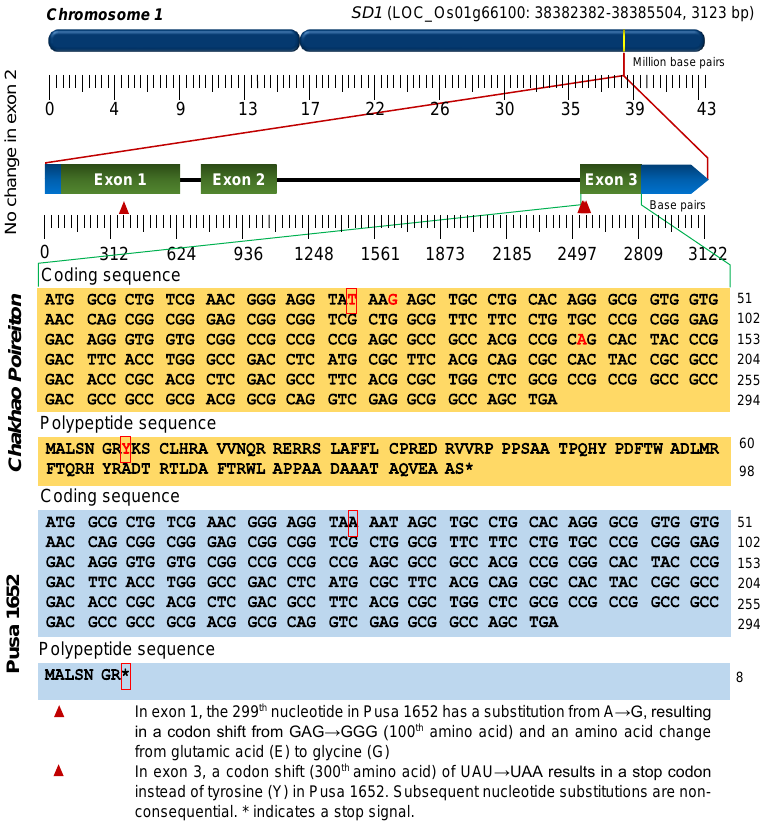
from glutamic acid (E) to glycine (G) In exon 3, a codon shift (300 th amino acid) of UAU→UAA results in a stop codon instead of tyrosine (Y) in Pusa 1652. Subsequent nucleotide substitutions are non- consequential. * indicates a stop signal. Figure 2. Variations in the amino acid sequence of the SD1 protein from Chakhao Poireiton and Pusa 1652. Exon 1 had an amino acid substitution at the 100th position, which changed glutamic acid to glycine in Pusa 1652. There was no variation observed in exon 2, while exon 3 had a stop codon introduced at the 300th amino acid position in Pusa 1652, resulting in the premature termination of GA20 oxidase 2 in exon 3.